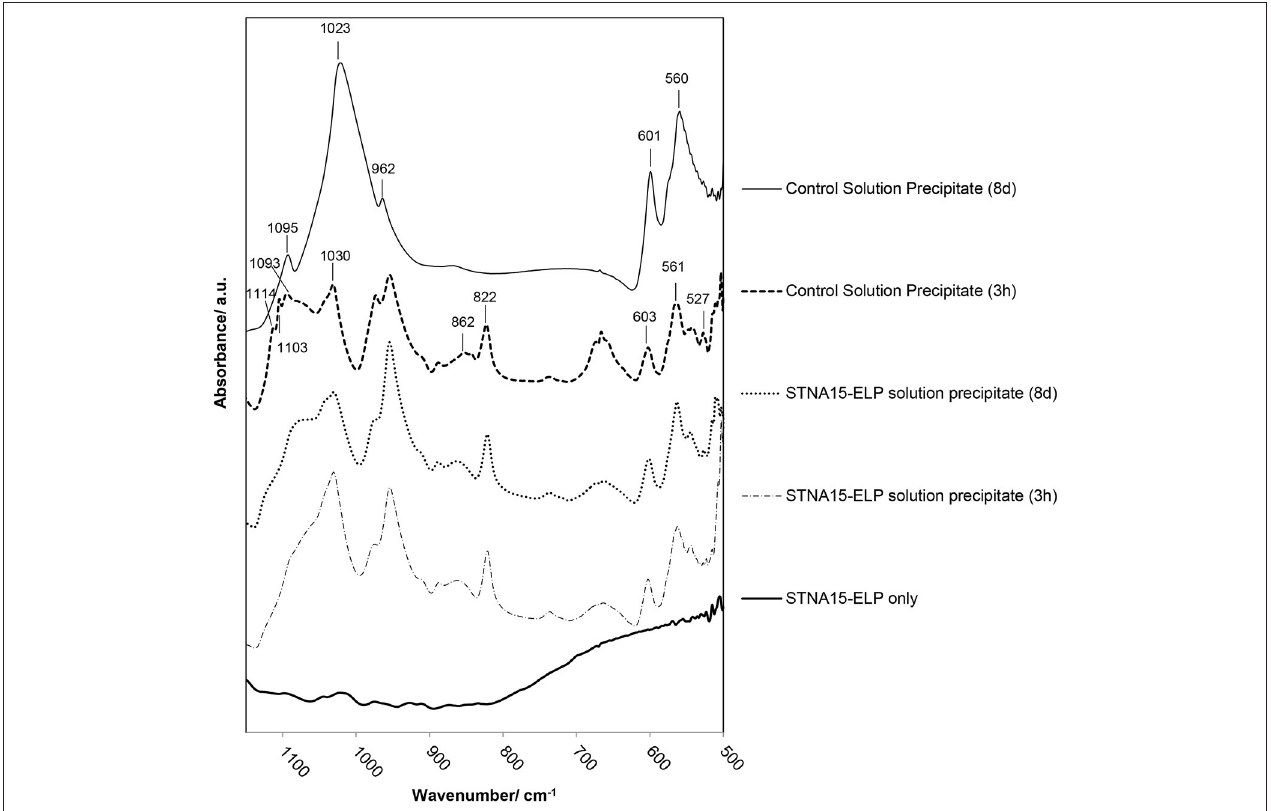
FIGURE 8 | FTIR analysis of precipitate formed in solution with and without STNA15-ELP. Without STNA15-ELP OCP forms at 3h, transforming to highly crystalline FAp at 8 days. The ELP promotes FAp formation, with the FTIR indicating the presence of nano-crystalline FAp at 3 h and 8 days. (820 cm − 1 : residual NO 3 ).